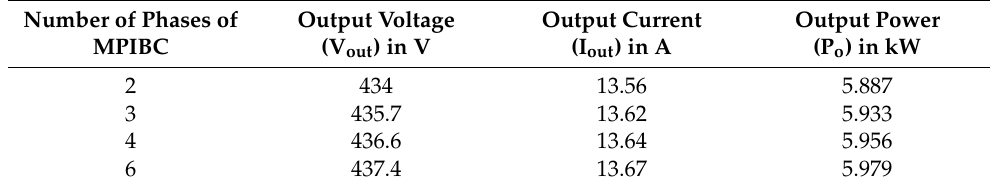
Table 6. Output parameter values of MPIBC (input voltage: 200